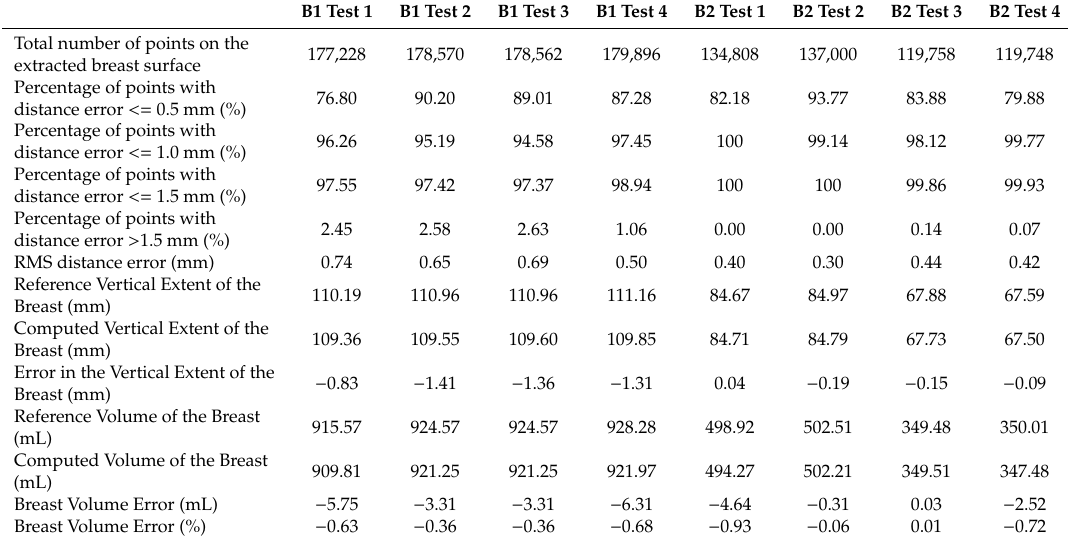
Table 2. Summary of the accuracy results on eight 3D breast surface reconstruction tests involving the B1 and B2 breast